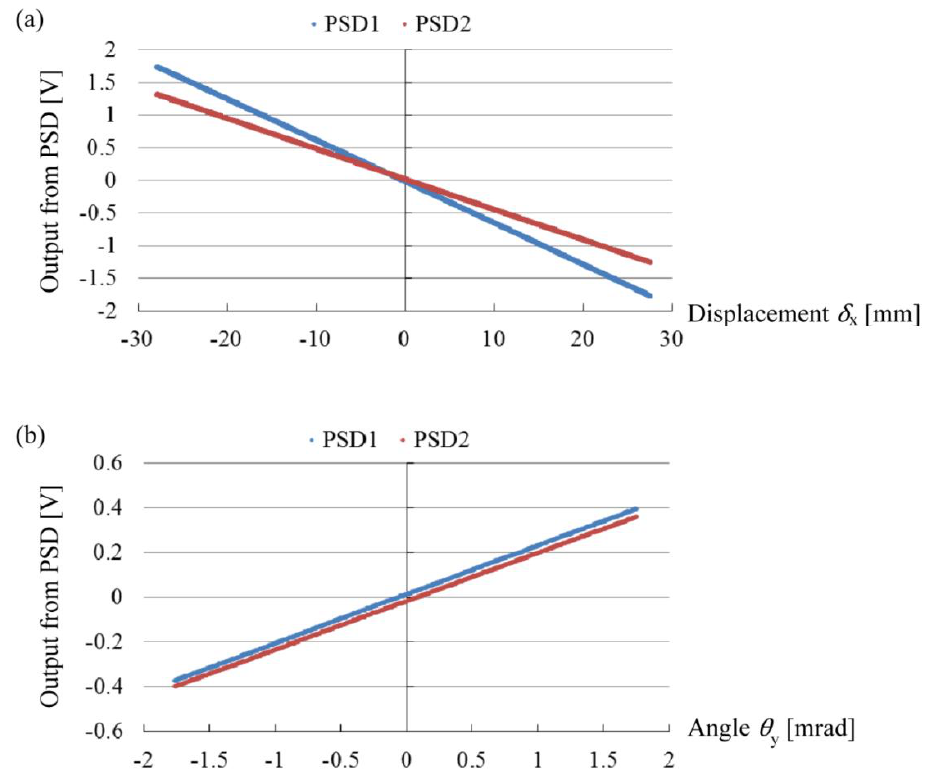
Figure 5. Output voltages from the PSD units according to (a) the lateral displacement δ and (b) the inclination angle θ